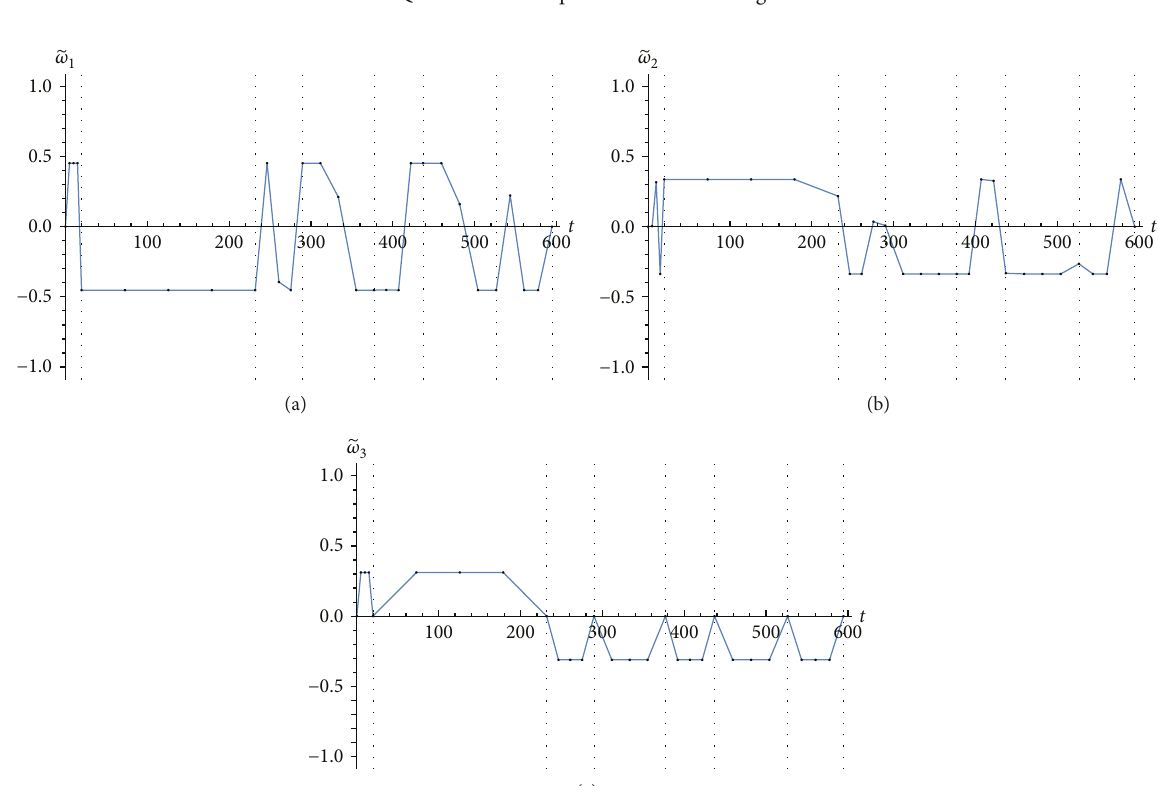
Figure 4: Angular velocity of the spacecraft in experiment A with 6 target